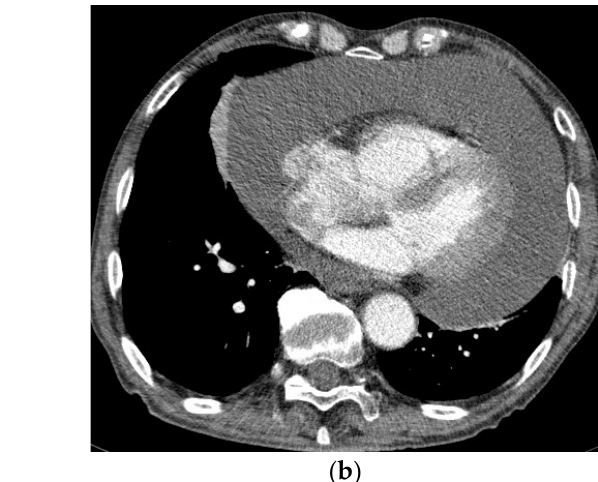
Figure 3. Chest MRI. T2-weighted image, axial view ( a ) T1 weighted image with fat saturation and with contrast enhancement, sagittal view ( b ). Large pericardial effusion is seen, hyperintense on T2- weighted image ( a ) and hypointense on a T1-weighted image ( b ).